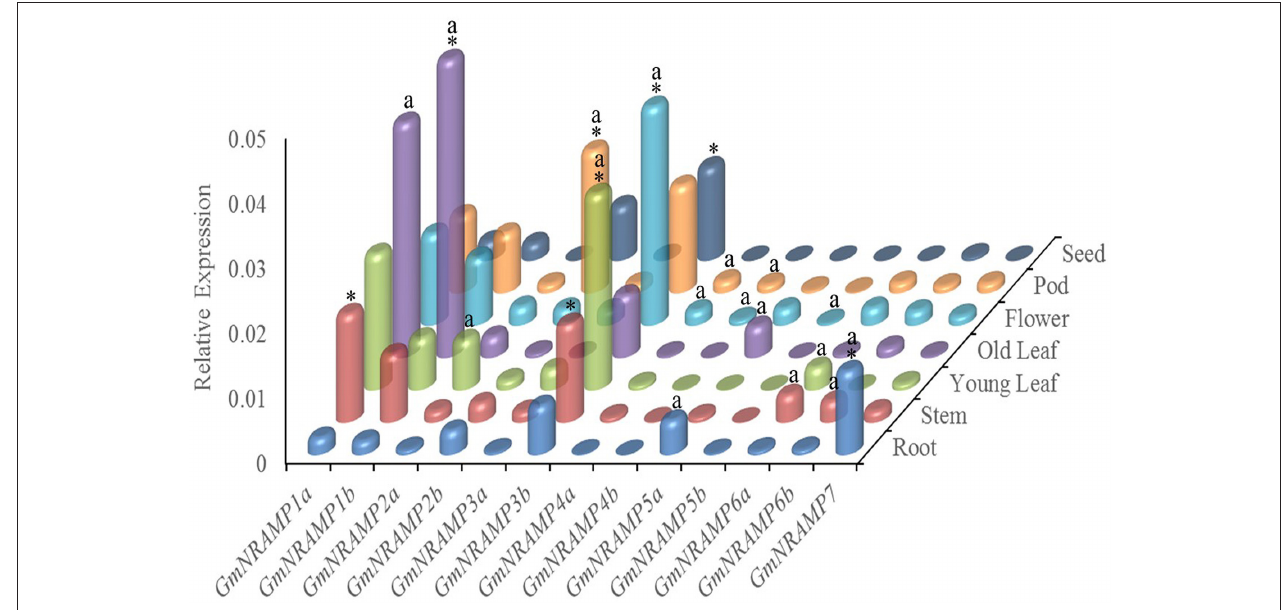
FIGURE 4 | Tissue-specific expression profiles of GmNRAMP genes. Quantitative RT-PCR analysis of GmNRAMP genes was performed in various soybean tissues. Soybean seedlings were grown for 40 days in hydroponic cultures prior to separately harvesting young leaves (YL), older leaves (OL), stems (ST), roots (R), and flowers (F). Then, at 55 days, young pods (P) and seeds (SE) were separately harvested. Relative expression levels were obtained by real-time PCR normalized against the reference gene TefS1 . Each bar is the mean of four biological replicates with standard error. Differential expression was tested among tissues for each gene, and among genes for each tissue by ANOVA tests followed by the Duncan’s Multiple Range Test for mean separation. The letter “a” marks tissues in which each gene is most highly expressed, and an “*” marks the genes that are most highly expressed in each